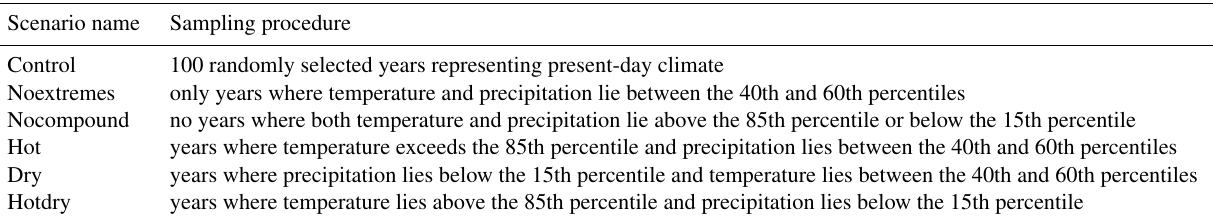
Table 1. Sampling design for the six climate scenarios (see Tschumi et al.,